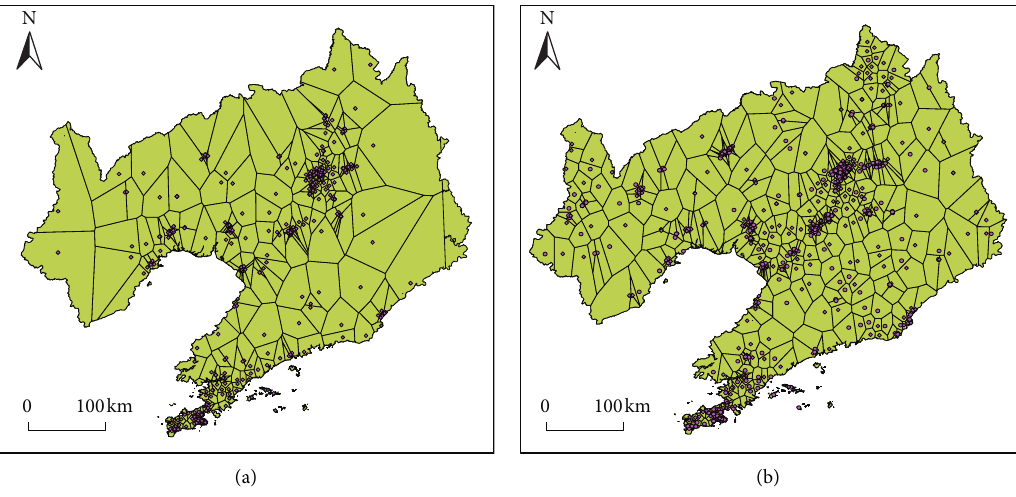
Figure 6: Voronoi maps of secondary schools in Liaoning Province (a) in 2008 and (b) in